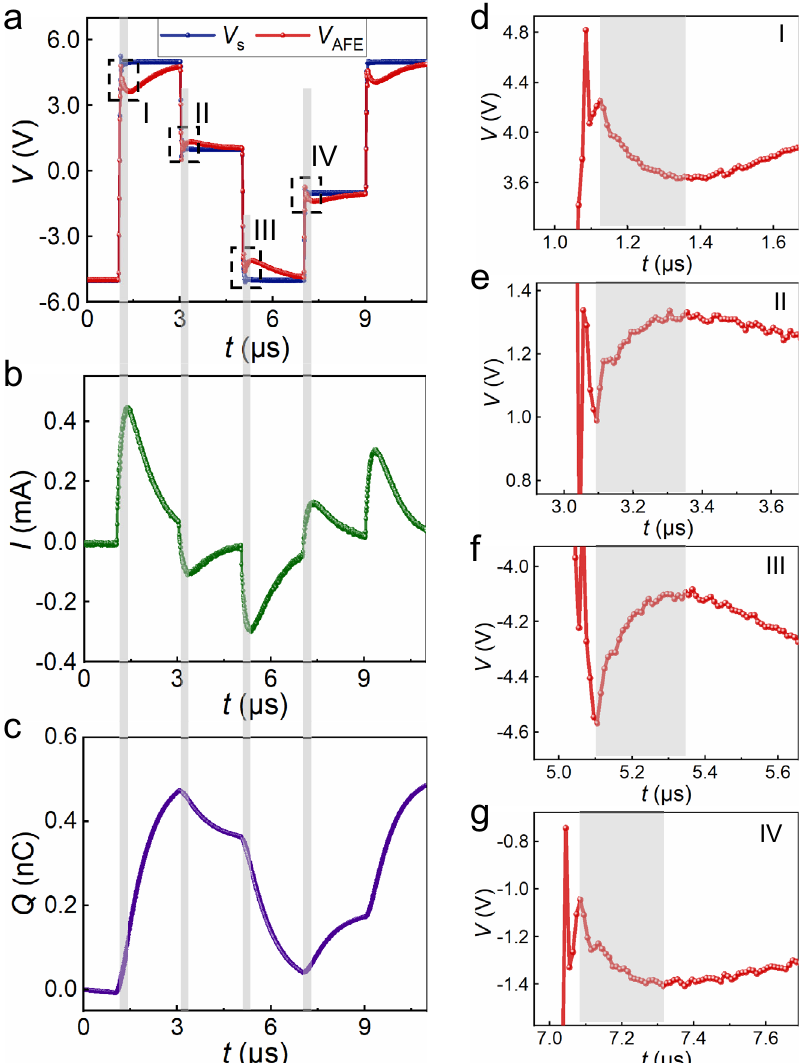
Fig. 3 Transient responses of an antiferroelectric capacitor under different pulse operation processes. Transients corresponding to a source voltage V s and the antiferroelectric voltage V AFE , b current I through the circuit, c charge Q on the application of an a.c. voltage pulse V s : − 5 → + 5 → + 1 → − 5 → − 1 → + 5 V. R = 3 k Ω . NC transients are observed at the shadow areas of regions I, II, III, and IV, which are magni fi ed in d , e , f , and g respectively. The source voltage V s is shown as the blue line and V AFE transient as the red.